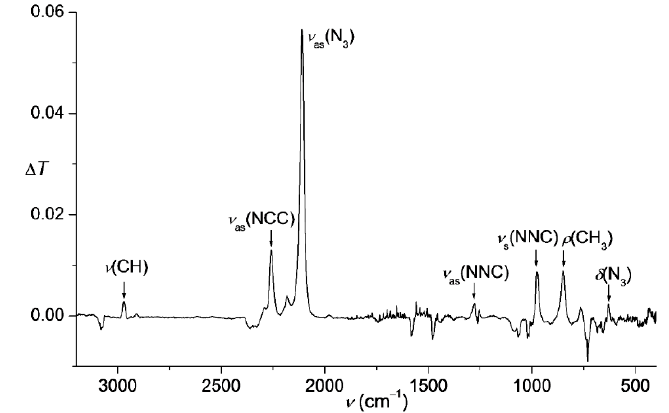
Figure 1. IR difference spectrum showing the changes before and after thermal decomposition of gaseous Me 3 SiCCN 3 ( 6 ) in the range of 3200–400 cm − 1 . The bands pointing downwards belong to unidentified decomposition product. Band positions of 6 are 2970, 2259, 2183, 2110, 1277, 976, 850, 629 cm ´ 1 .